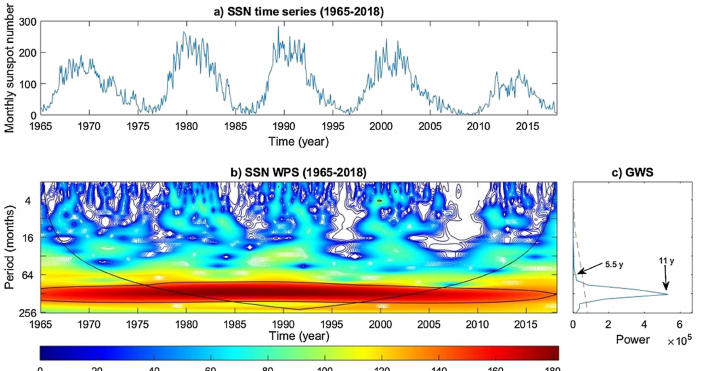
Figure 2. Example of a wavelet powerspectrum on the Sunspot number time-series. ( a ) Time-series of the daily values of sunspot number. ( b ) Wavelet power spectrum; the wavelet power display is colour-coded with red corresponding to the maxima, while the black contour is the cone of influence of the spectra, where edge effects in the processing become important. ( c ) Global wavelet spectrum and its confidence level (dashed line) above 95%. Source: Tsichla et al. 2019